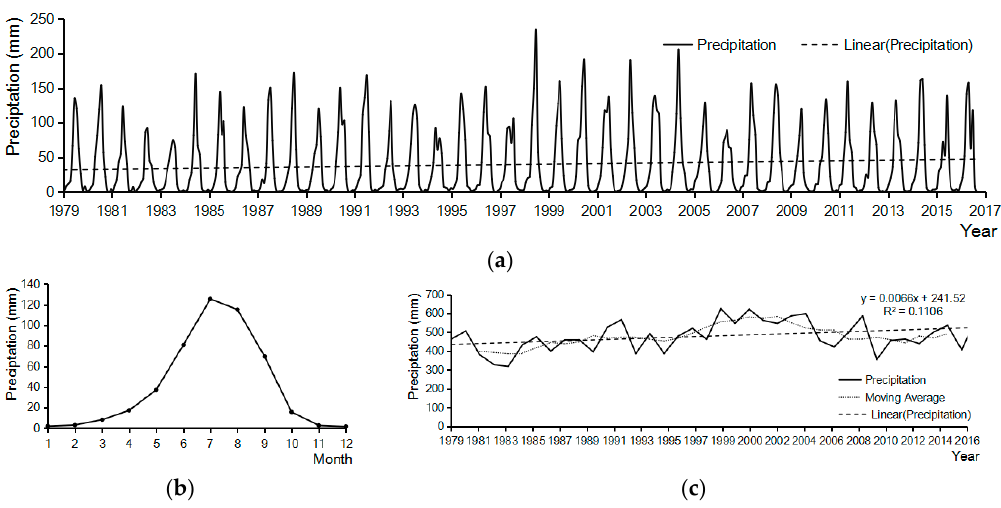
Figure 3. Characteristics of precipitation change in the midstream region of the Yarlung Zangbo River basin. ( a ) Time series of mean monthly precipitation; ( b ) The secular mean monthly precipitation; and,